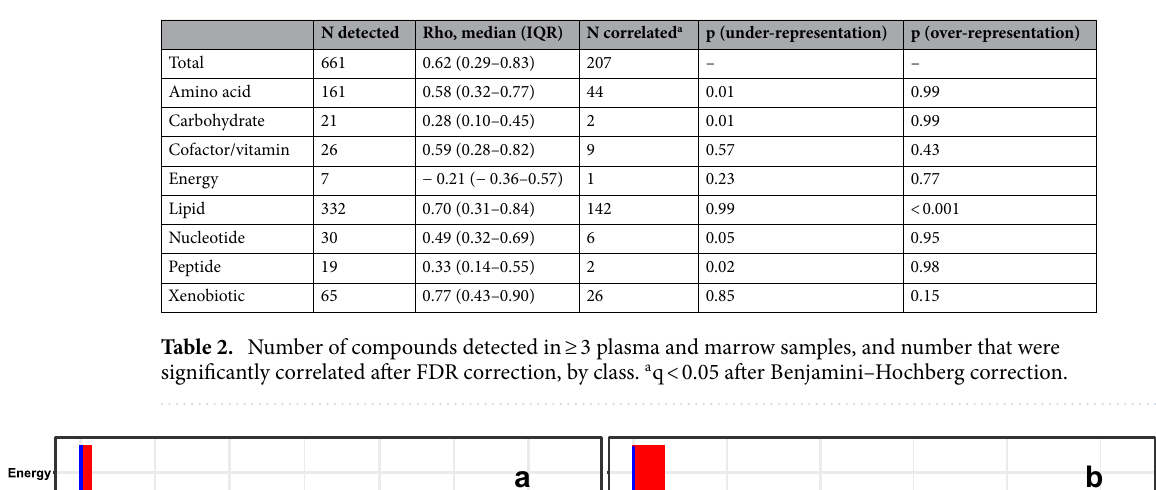
N detected Rho, median (IQR) N correlated a p (under-representation) p (over-representation)